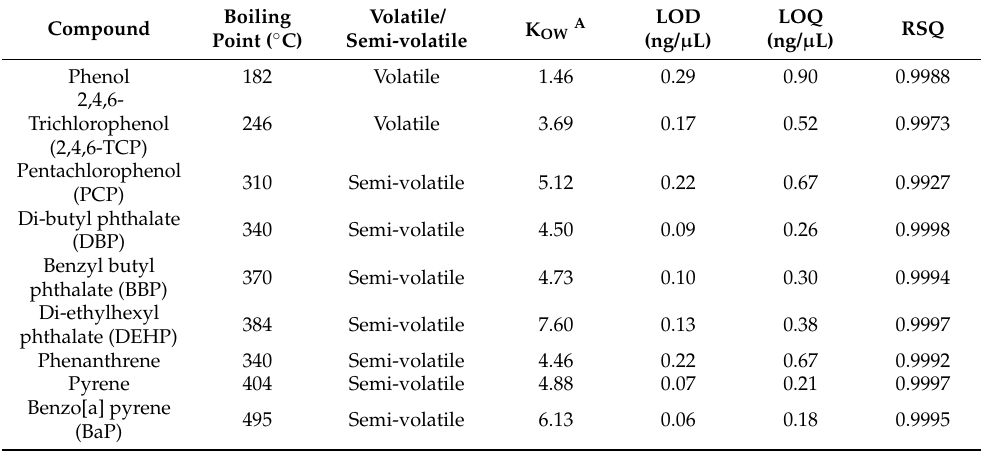
Figure 1. Schematic of the turnout suit. Table 1. Targeted Contaminants and their relevant properties.